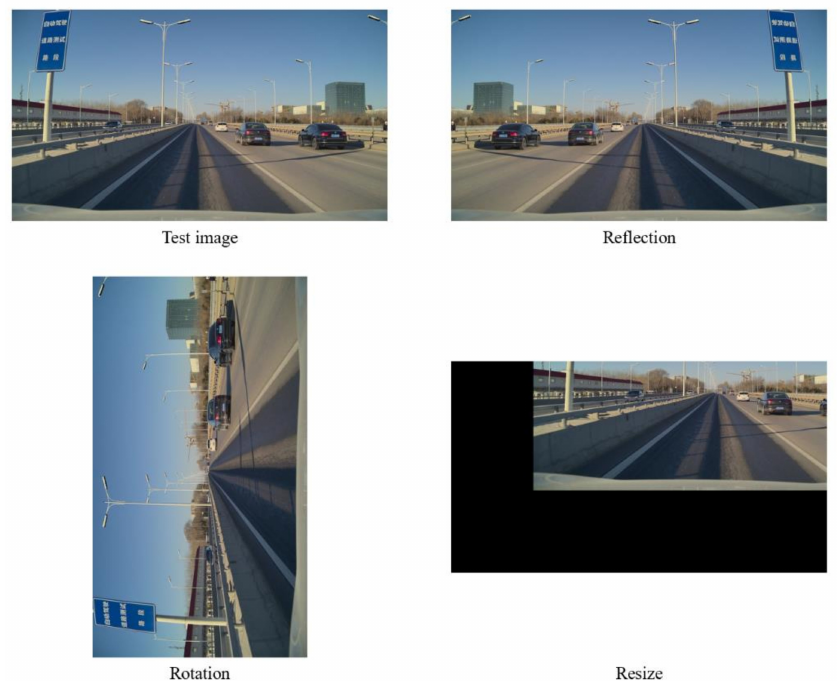
Figure 8. Some data augmentation methods that can be used in many classification tasks but cannot be used in lane localization task. These transformed images do not match the feature distribution of the test set. That is, the images in the test set are not likely to have such variation. The generalization capability enhanced by this series of data augmentation actually reduces the model performance in the test set. If the test set collects these types of images in a real-world scene, the system would judge that the camera is damaged or